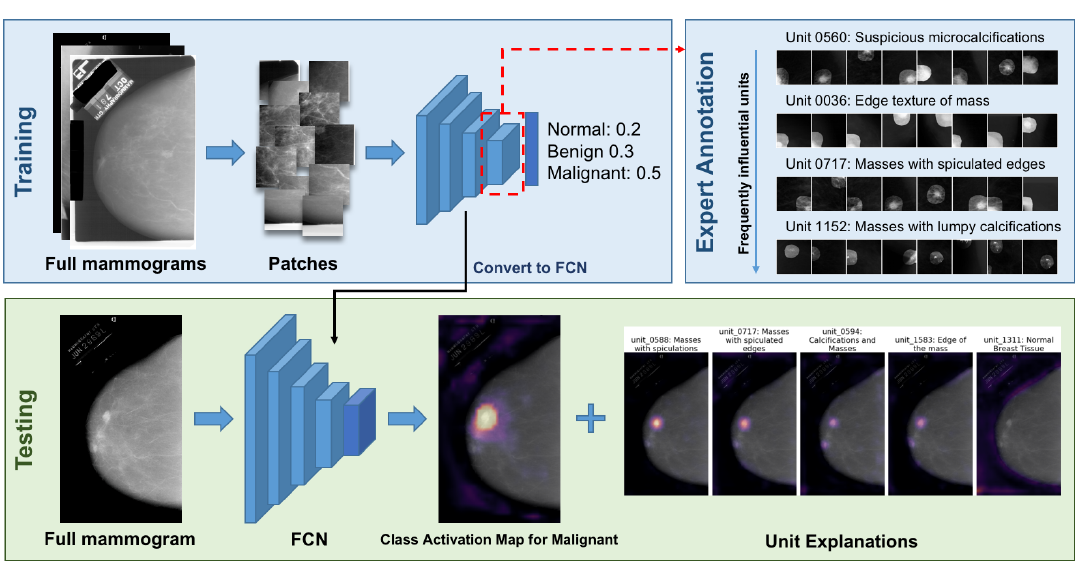
Figure 1. The DeepMiner framework: Illustration of our framework for mammogram classification and